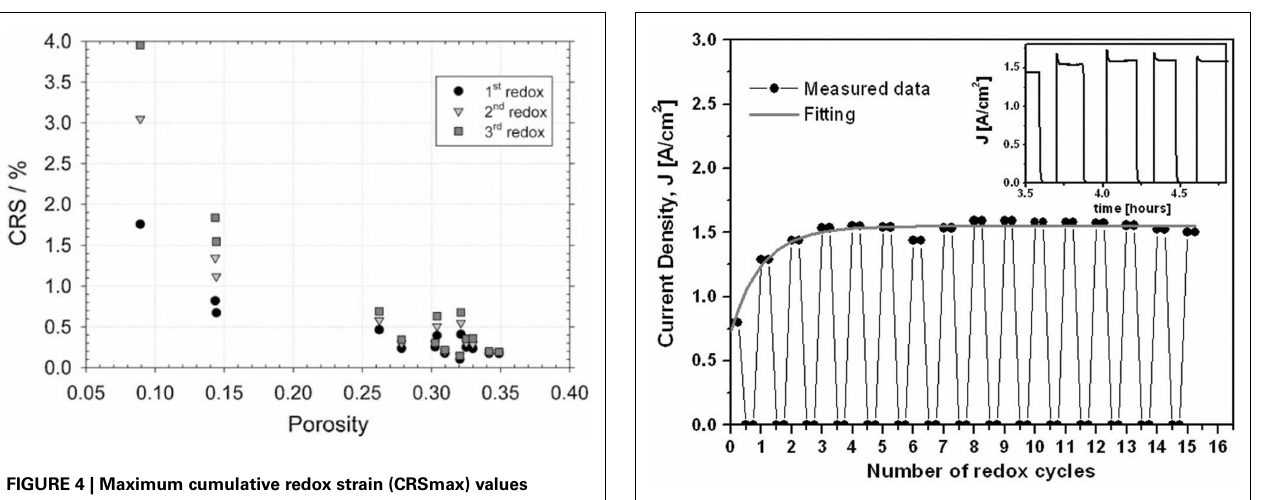
FIGURE 5 | Influence of redox cycles on the current density at short circuit conditions at 800°C .The inset graph shows the change in short circuit current density in time between 7th and 10th redox cycles at 800°C (Buyukaksoy et al., 2012). Reprinted with permission fromThe Electrochemical